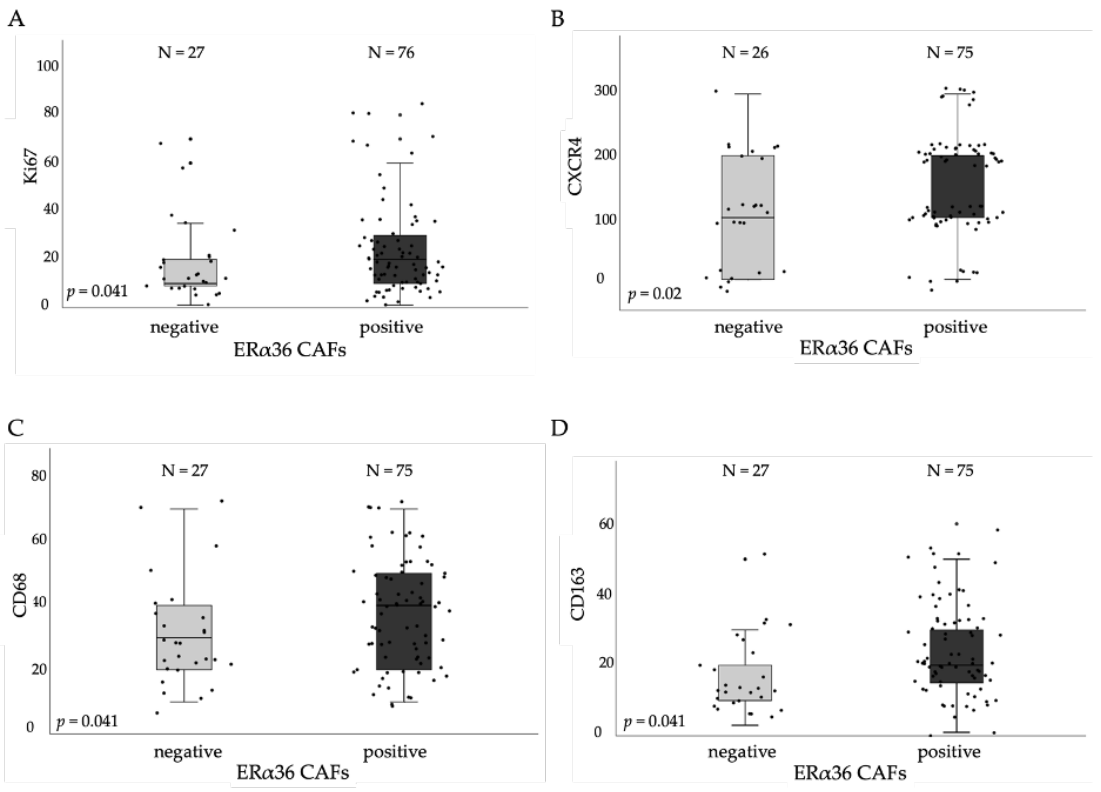
Figure 4. Levels of protein expression in CAFs subgroups, ( A ) Ki67 expression in ER α 36 negative and positive CAFs groups, ( B ) CXCR4 expression in ER α 36 negative and positive CAFs groups, ( C ) CD68 expression in ER α 36 negative and positive CAFs groups, ( D ) CD163 expression in ER α 36 negative and positive CAFs groups. Mann-Whitney U test was used in the analysis.